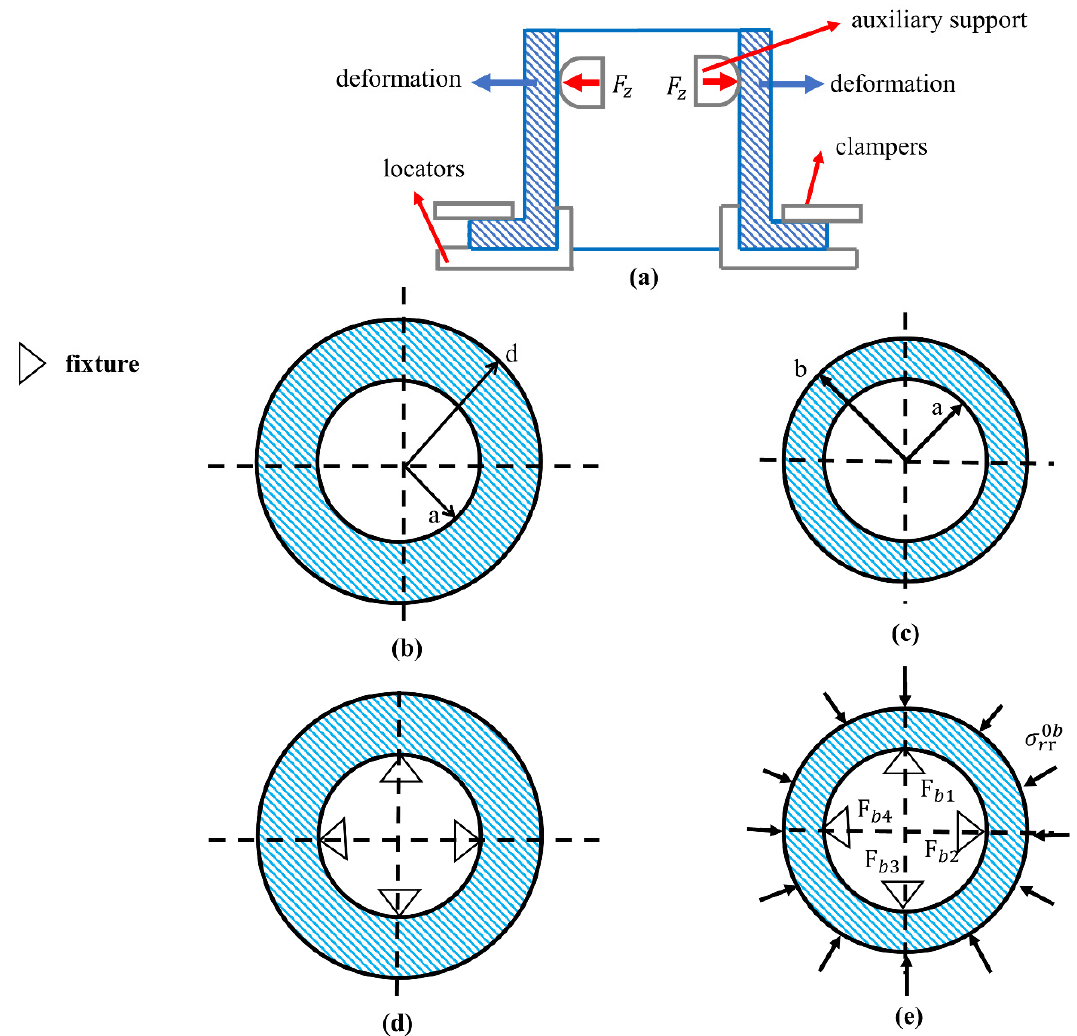
Figure 1. Clamping of an areo-engine casing and mechanism of residual stress release . ( a ) Clamping of an areo-engine casing; ( b ) Blank; ( c ) Part; ( d ) Clamping state before processing; ( e ) Clamping state after processing.